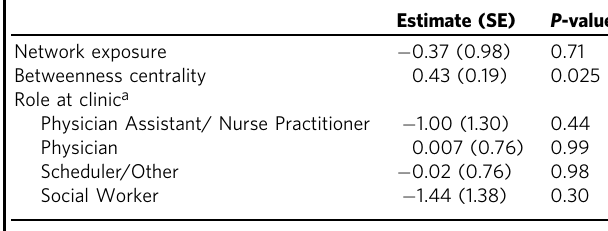
Table 3 Multivariable logistic regression on patient referrals in discussion